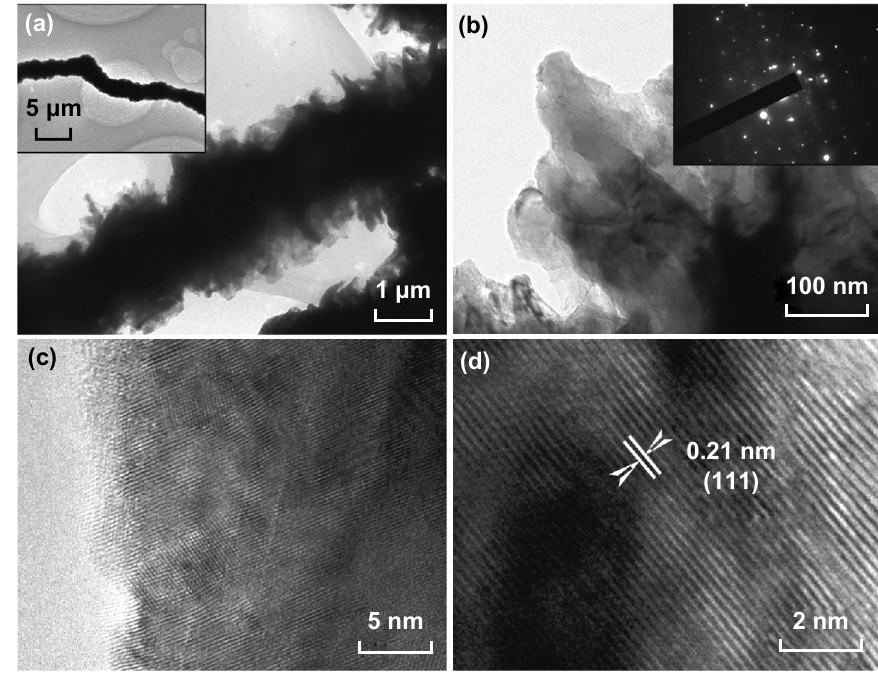
Fig. 2 a – d TEM and HRTEM images of N-SN. The inset images in ( a , b ) show a low-magnification TEM image and the SAED